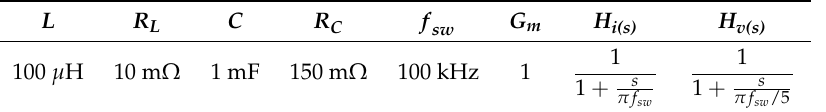
Table 3. Key parameters of the bidirectional buck-boost